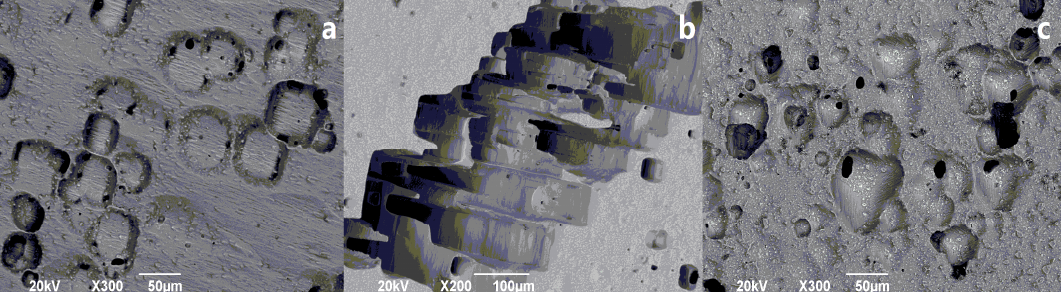
Figure 3. Corrosion patterns on different crystal directions after eight days: ( a ) (100); ( b ) (110), and ( c ) (111).